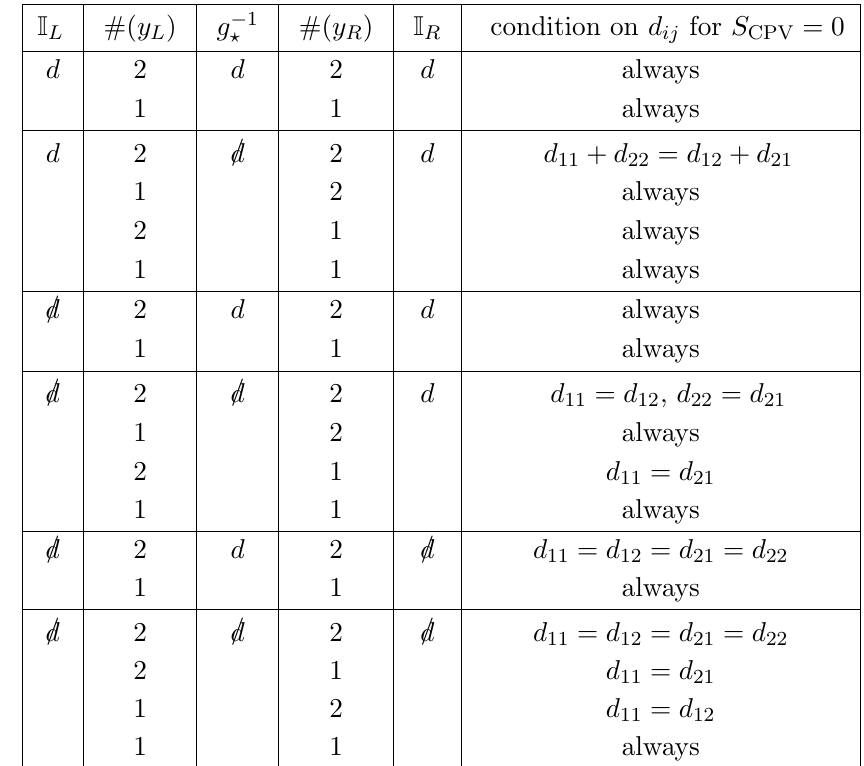
always Table 1 . List of the possible choices for the components of the quark mass matrices written as m ij (cid:24) ( I L ) ( y L ) ( g (cid:0) 1 ) ( y R ) y ( I R ), and conditions under which the resulting CP-violating source ? vanishes. These conditions are given in terms of the quantities d ij de(cid:12)ned in eq. (5.7), where an index 1 (2) is for the top (charm). The symbols d and =d stand respectively for a diagonal and anarchic structure of the corresponding matrices. Furthermore, #( y ) denotes the number of non- L=R vanishing components of ( y ) ii . We do not present the cases f I L ; g (cid:0) 1 ; I R g = f d; d; =d g ; f d; =d; =d g L=R ? which are analogous to respectively f =d; d; d g ; f =d; =d; d g